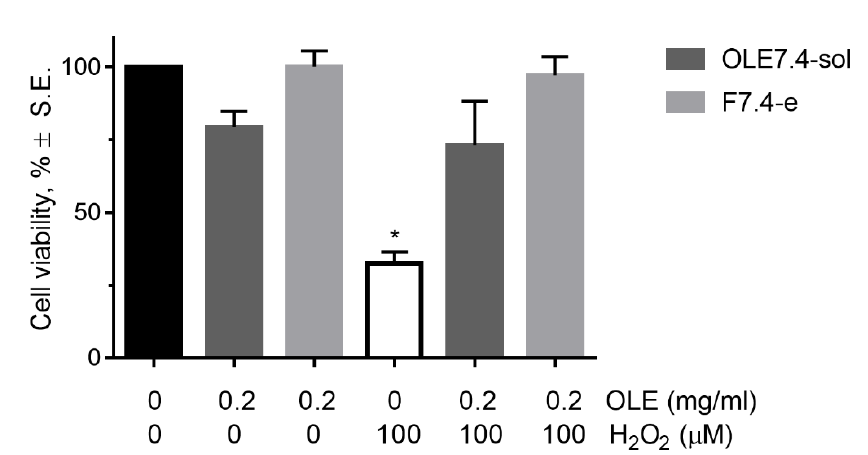
Figure 7. Cell viability of RCE cells after contact with OLE formulations and H 2 O 2 , alone (white bar) or after pre-treatment with OLE formulations. Black bar represents the untreated control. * p < 0.05 significant versus all other.